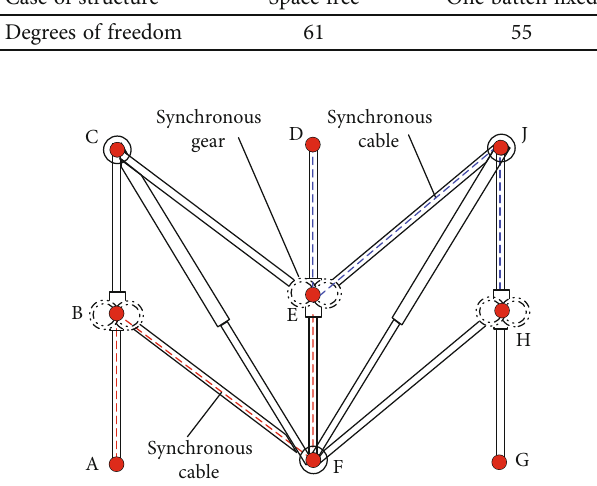
Figure 8: Truss element with synchronous constraints.